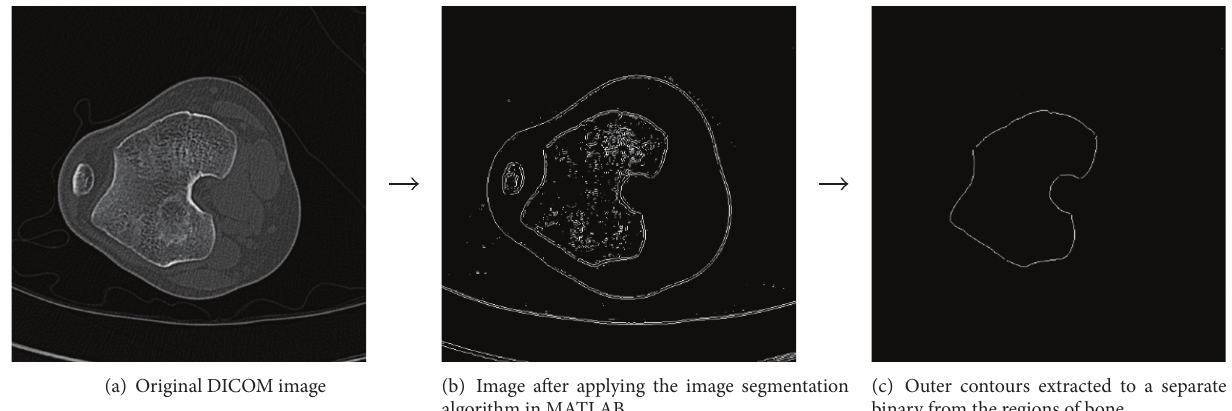
Figure 1: Segmentation procedure for the knee joint by the Sobel operator algorithm.